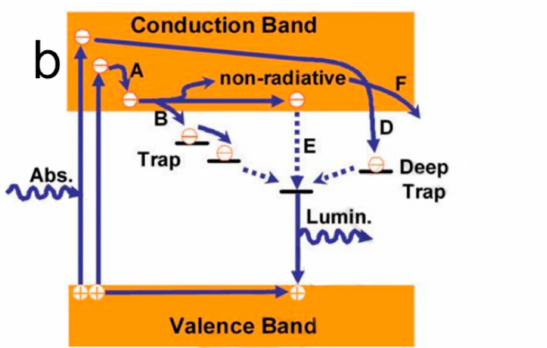
Figure 2. Trapping and recombination of photogenerated charge carriers of ( a ) anatase and ( b ) rutile TiO 2 . Adapted with permission from Ref.